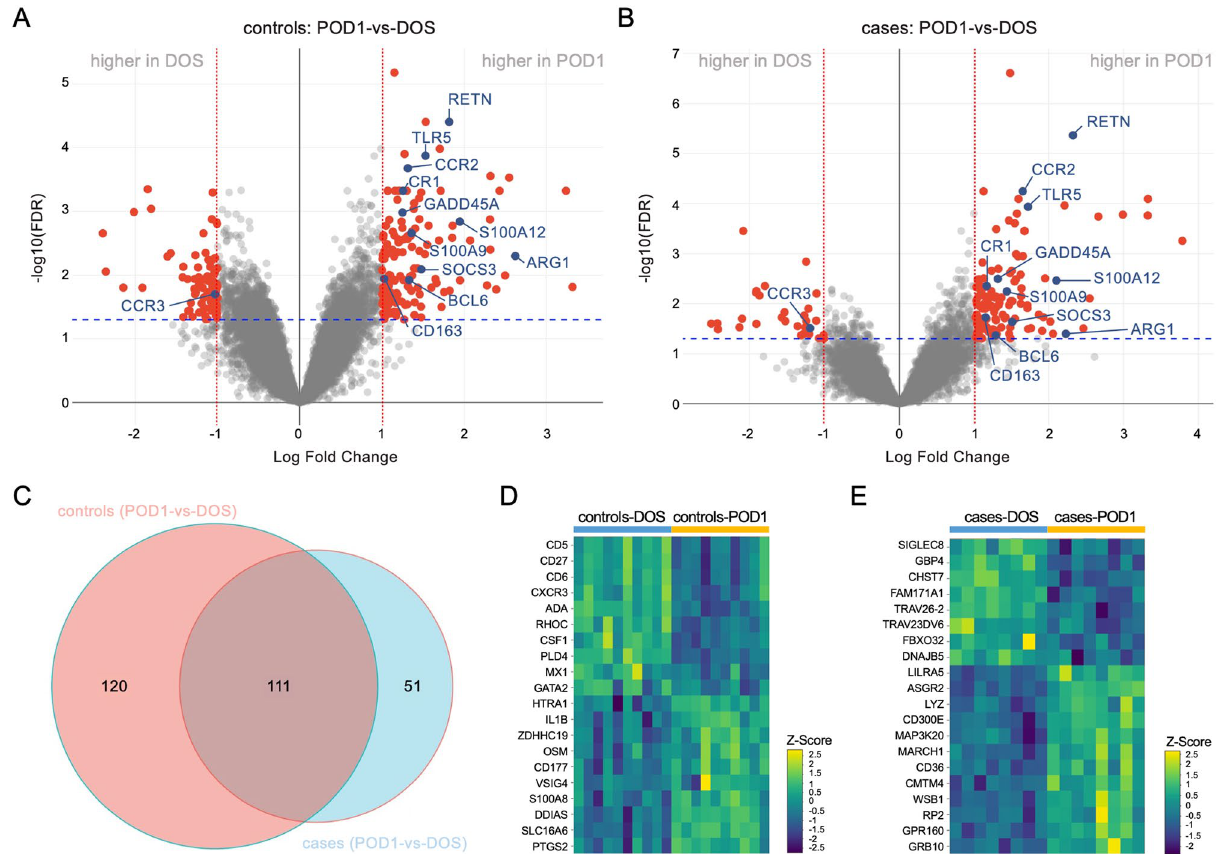
Figure 4. Transcriptomics analyses of PAXgene blood RNA identifies different gene signatures in cases (stiff knees) and controls following total knee arthroplasty. Volcano plots representing differentially expressed genes at 24 h after surgery (POD1) relative to the day of surgery (DOS) in ( A ) controls (no stiffness, N = 10) and ( B ) cases (stiff knees, N = 8). Red dots correspond to genes with significant changes greater than 1 log2-fold expression change (FDR < 0.05, LogFC > 1). Selected DEGs common to cases and controls are highlighted in blue. ( C ) Venn diagram representation of the DEGs at POD1 compared to DOS that are common to cases and controls (N = 111) or unique to controls (N = 120) and cases (N = 51). Heatmap representation of selected DEGs that are unique to ( D ) controls and ( E ) cases is shown. Data were z-score and controls at baseline, in DOS samples. Relative to DOS levels, we found different transcriptional profiles at POD1 in cases versus controls, as shown in the volcano plot representation of the DEGs (FDR < 0.05, LogFC > 1) for each group. Specifically, RNA-seq analyses uncovered 231 DEGs at POD1 in controls (Fig. 4A) and 162 DEGs in cases (Fig. 4B). The Venn diagram representation in Fig. 4C depicts the unique and overlapping genes in cases and controls. We identified 111 overlapping DEGs for cases and controls, including ARG1, CCR2, CCR3, RETN, S100A9, S100A12, and TLR5 (Fig. 4A–B), which represent a general response to TKA. Notably, the control group displayed 120 unique DEGs, including inflammatory mediators and damage-induced genes like IL1B, OSM, PTGS2, and S100A8 (Fig. 4D). The cases displayed 51 unique DEGs at POD1 relative to DOS, including CD36, GBP4, LYZ and MARCH1 (Fig. 4E). Thus, comparison of cases versus controls uncovered attenuated and more variable responses to surgery in cases, with 231 DEGs at POD1 in controls versus the 162 DEGs identified in cases. See Supplementary Table S6 for a summary of unique and overlapping genes in cases and controls. QuSAGE pathway analyses 22 using RNA-seq data also uncovered pronounced differences in cases and con- trols. Figure 5A summarizes the 97 differentially expressed signaling pathways identified in controls, comparing POD1 vs. DOS samples (FDR < 0.01), highlighting changes in the expression of the ATF2 pathway (Fig. 5B), path- ways relevant to cytokines and inflammatory responses (Fig. 5C), the canonical NF-κB pathway (Fig. 5D), and the activated TLR4 signaling (Fig. 5E) after surgery. Similar to the network analyses using the combined POD1 and DOS samples (not shown), network analyses using the DEGs in the control group identified a transcription factor regulatory network involving GATA2, GADD45A, and CXCR3 (Fig. 5F). This transcriptional network was absent in the cases. Functional analyses using RNA-seq data from cases revealed a quite different transcriptional profile. QuSAGE analyses only uncovered 14 differentially expressed pathways in cases, comparing POD1 vs. DOS (FDR < 0.01, Fig. 5G). The majority of these pathways were common between cases and controls. The only 2 pathways unique to cases were the matrisome associated (Fig. 5H) and the steroid hormone biosynthesis (Fig. 5I). Important pathways involved in inflammatory, stress, and healing responses, including canonical NF-κB, p38